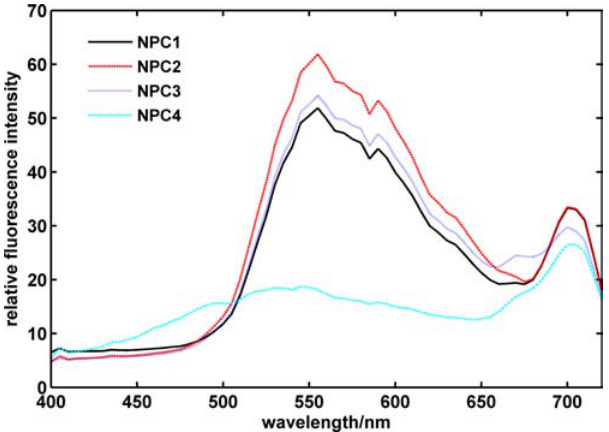
Fig. 4. The relative °uorescence intensity for the four negative CBTs.